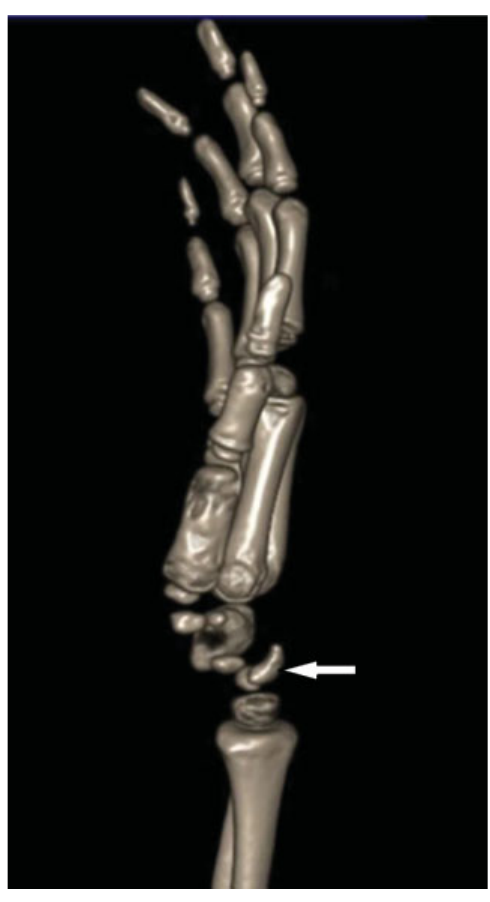
Fig. 1 Computed tomographic scan before surgery. Perilunate wrist dislocation lateral view.